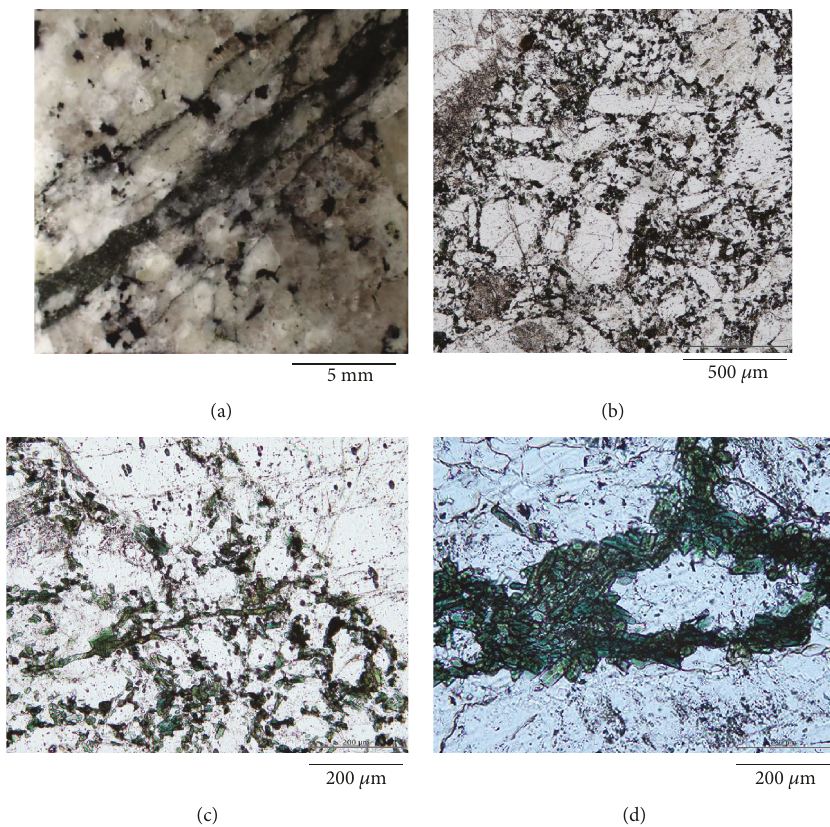
Figure 4: Close-up photograph and photomicrographs of the black glassy vein of Figure 2(d) (DH-13 553.87). (a) Close-up photograph of the black glassy vein (polished chip). (b) Quartz fragments and their bordering fi ne hornblende (thin section, open nicol). (c) Secondary microfracture (thin section, open nicol). (d) Euhedral hornblende aggregation (thin section, open